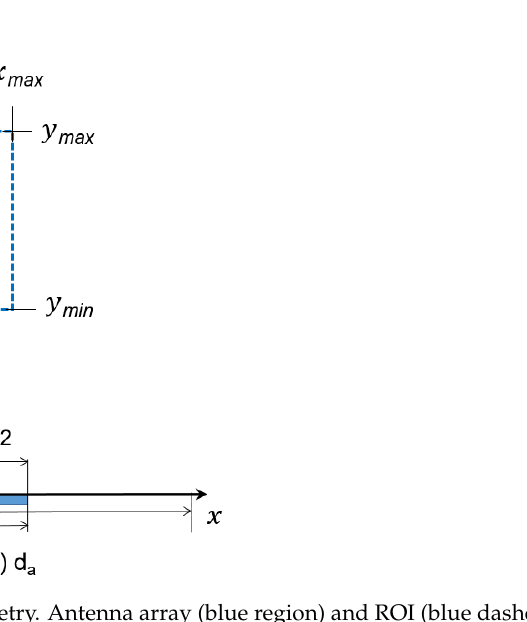
Figure 1. Considered geometry. Antenna array (blue region) and ROI (blue dashed line) are shown in the fi gure.